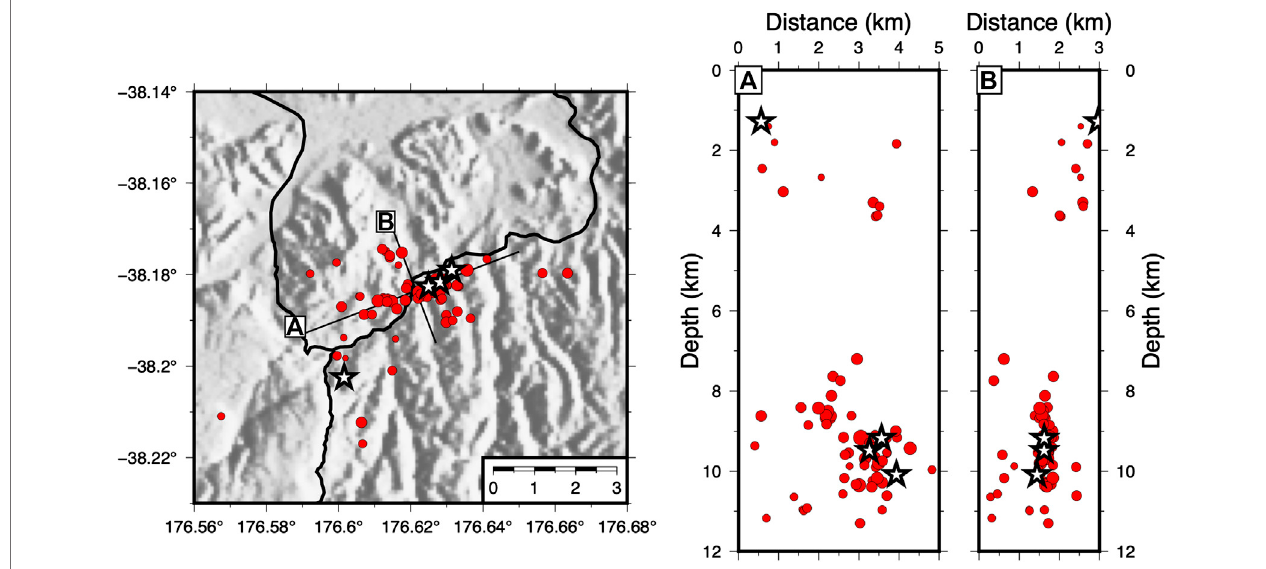
FIGURE 3 | Relocated earthquakes (red circles, scaled by magnitude) show a clear lineation striking at ∼ 70 ° . Along (A) and across (B) strike cross-sections show that these earthquakes are occurring on a vertical plane. White stars show the locations of earthquakes with calculated moment tensors, shown in Figure 5 .